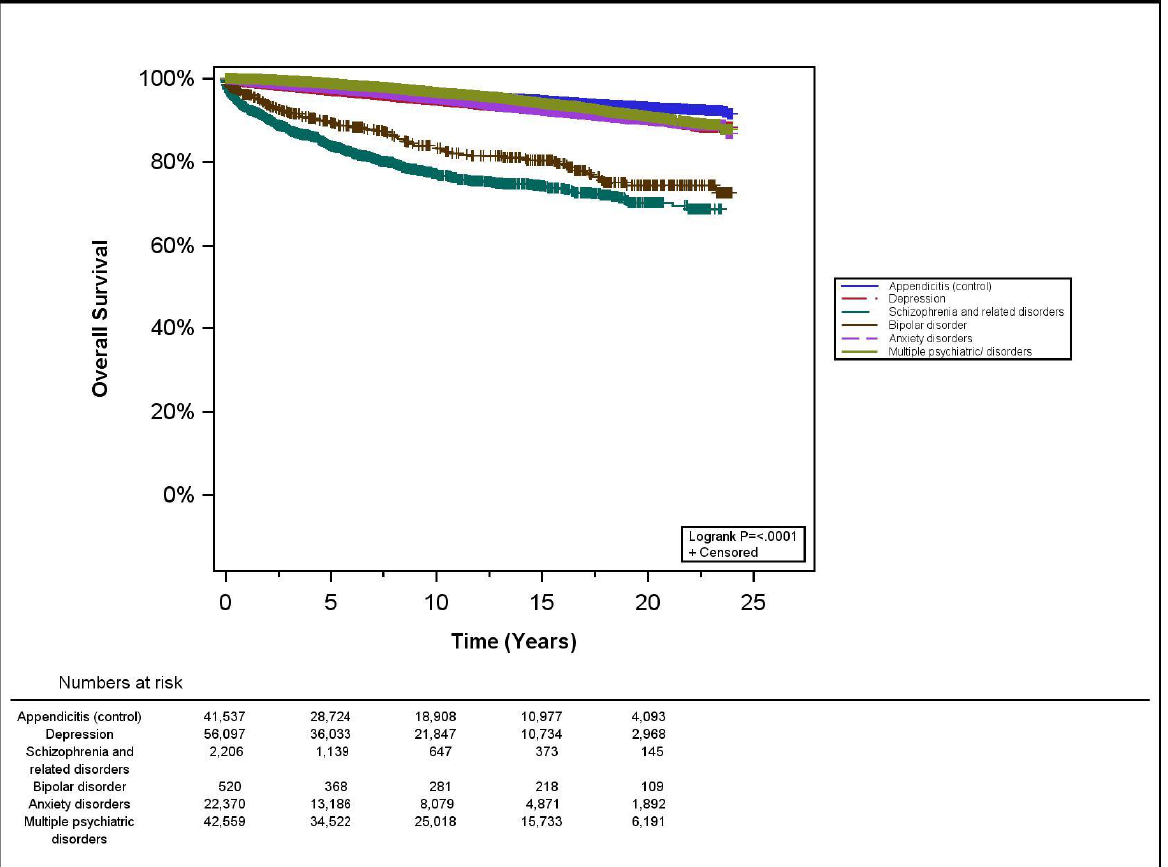
Figure 1. Kaplan – Meier estimates of overall survival by psychiatric disorder. Figure 1. Kaplan–Meier estimates of overall survival by psychiatric Table 2. Cox regression model used to estimate the effects of having a PD on survival.